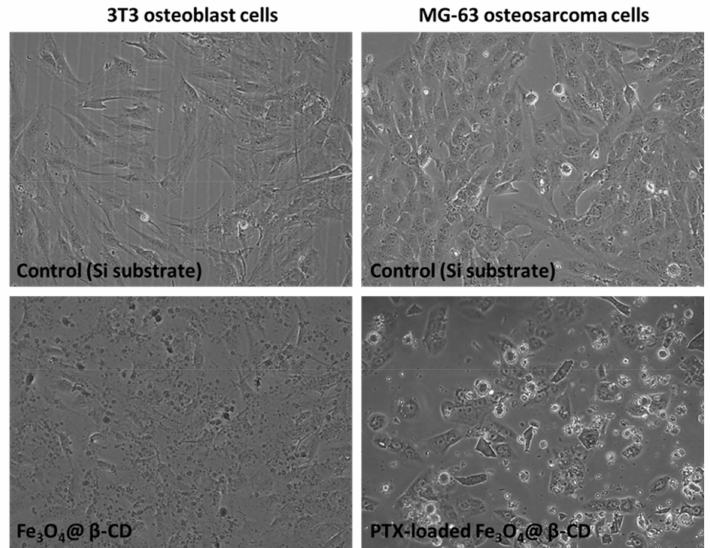
Figure 18. Images of phase-contrast microscopy of normal 3T3 osteoblasts and MG-63 osteosarcoma cells cultured on the surface of Fe 3 O 4 @ β -CD and PTX-loaded Fe 3 O 4 @ β -CD thin films, respectively. Objective used: 10 ×